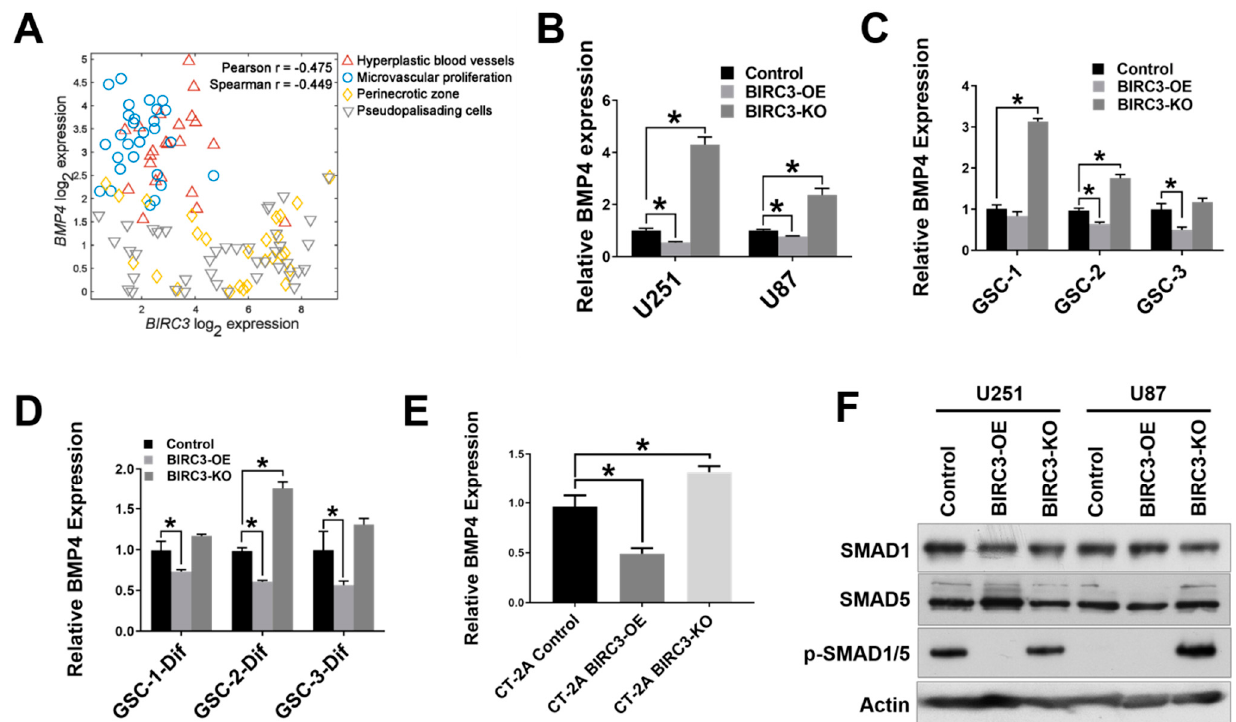
Figure 3. BIRC3 directs BMP4 signaling inhibition in GBM. ( A ). Analysis of correlation between BIRC3 and BMP4 expression in different regions of GBM using IVY dataset. Analyzed regions include hyperplastic blood vessels, microvascular proliferation region, perinecrotic zone and pseu- dopalisading cells region. ( B – D ). Human BMP4 mRNA expression analyzed by real time PCR in control, BIRC3-OE and BIRC3-KO cells including U251/U87 GBM cell lines, GSCs and differentiated GSCs. n = 3, * p < 0.05. ( E ). Mouse BMP4 mRNA expression analyzed by real time PCR in control, BIRC3-OE and BIRC3-CT-2A cells. n = 3, * p < 0.05. ( F ). Protein expression of SMAD1, SMAD5 and phosphorylated SMAD1/5 in U251/U87 control, BIRC3-OE and BIRC3-KO cells. Specific antibodies as indicated. β -actin acts as internal control.